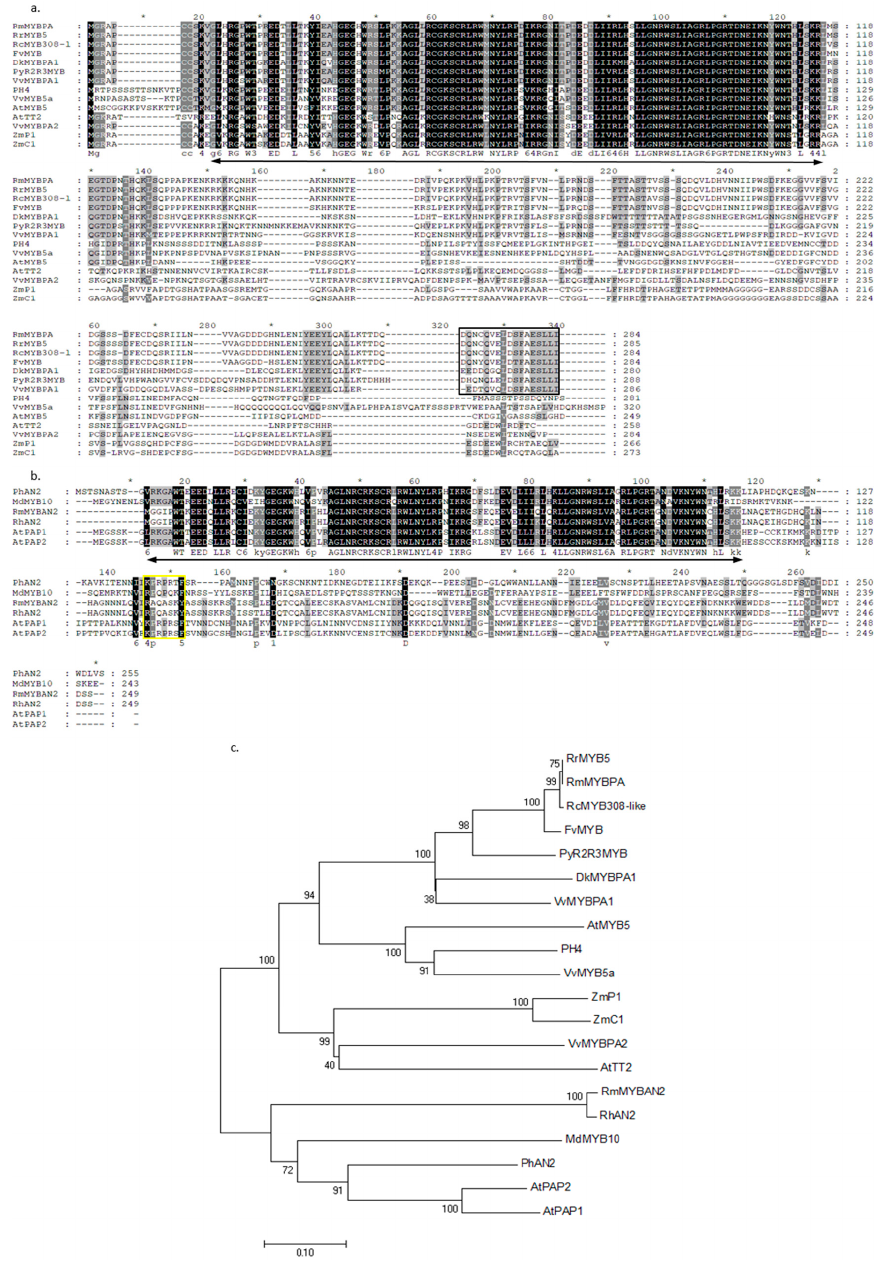
Figure 6. Analysis of deduced amino acid sequences of two R2R3-MYB TFs. ( a ) Alignment of deduced amino acid sequences of the AN2 subgroup of MYB TFs, and ( b ) alignment of deduced amino acid sequences of the TT2 and PA specific-MYB regulators. ZmC1, ZmPl (maize), AtTT2, AtMYB5 ( Arabidopsis thaliana ), PH4 ( Pharbitis hybrid ), VvMYB5a, VvMYBPA1, VvMYBPA2 ( Vitis vinifera ), PyR2R3MYB ( Prunus yedoensis ), DkMYBPA1 ( Diospyros kaki ), RrMYB5 ( Rosa rugusa ), RhMYB308-like ( Rosa chinensis ), and FvMYB ( Fragaria vesca ). The R2R3MYB domains are indicated by black arrow, yellow box indicates a C-terminal conserved motif [K / R]Px3[K / T][F / Y] in AN2 subgroup of R2R3MYB. Black box indicates a C-terminal conserved motif in the PA-specific MYB regulators. ( c ) A neighbor-joining phylogenetic tree of plant R2R3MYB sequences. The scale bar represents 0.1 substitutions per site and the numbers next to the nodes are bootstrap values from 1000 replicates. The deduced amino acid sequences were retrieved from the DDBJ / EMBL / GeneBank databases, and the accession numbers are as follows AtPAP1(NP_176057.1), AtPAP2(NP_176813.1), RhAN2(BAM36703.1), PhAN2(AAF66727.1), MdMYB10(AAF66727.1), and ZmC1(sp |